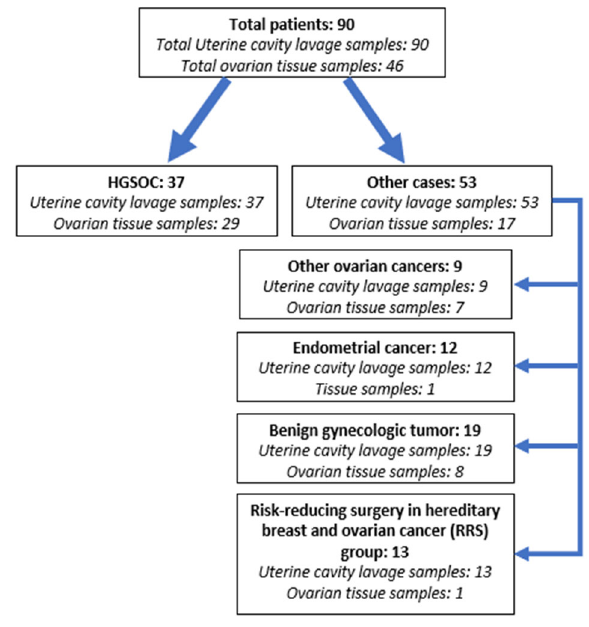
Figure 1. Schematic representation of the study cohort. The clinical features of the patients and the pathological features of the tumour in- cluded in the study are provided in Table 1. Table 1. Clinical ‐ pathological characteristics of the study cohort.